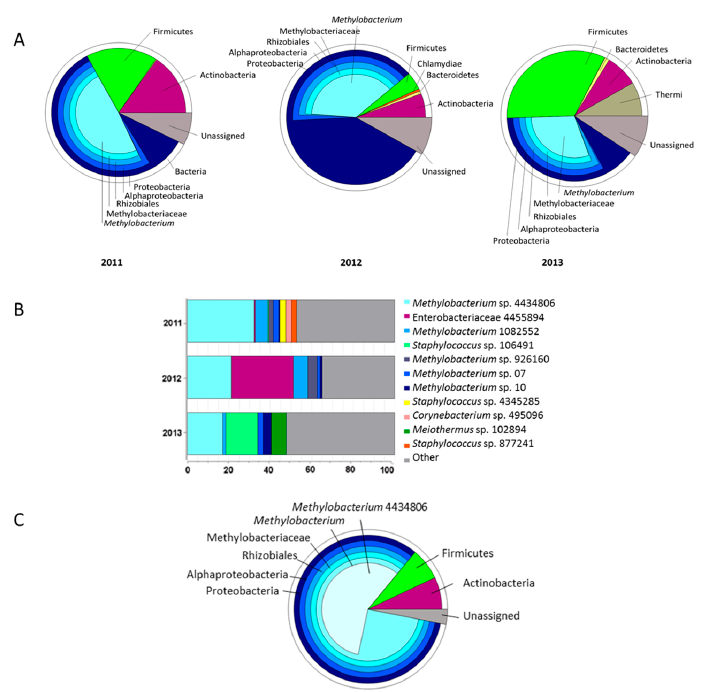
Figure 1. Composition of the core microbiome of Crotalaria pumila seeds throughout three consecutive generations. Average of core microbiome in each generation ( A ); and, identification of the most abundant taxon in each generation ( B ) and in the core microbiome over the three generations ( C ).